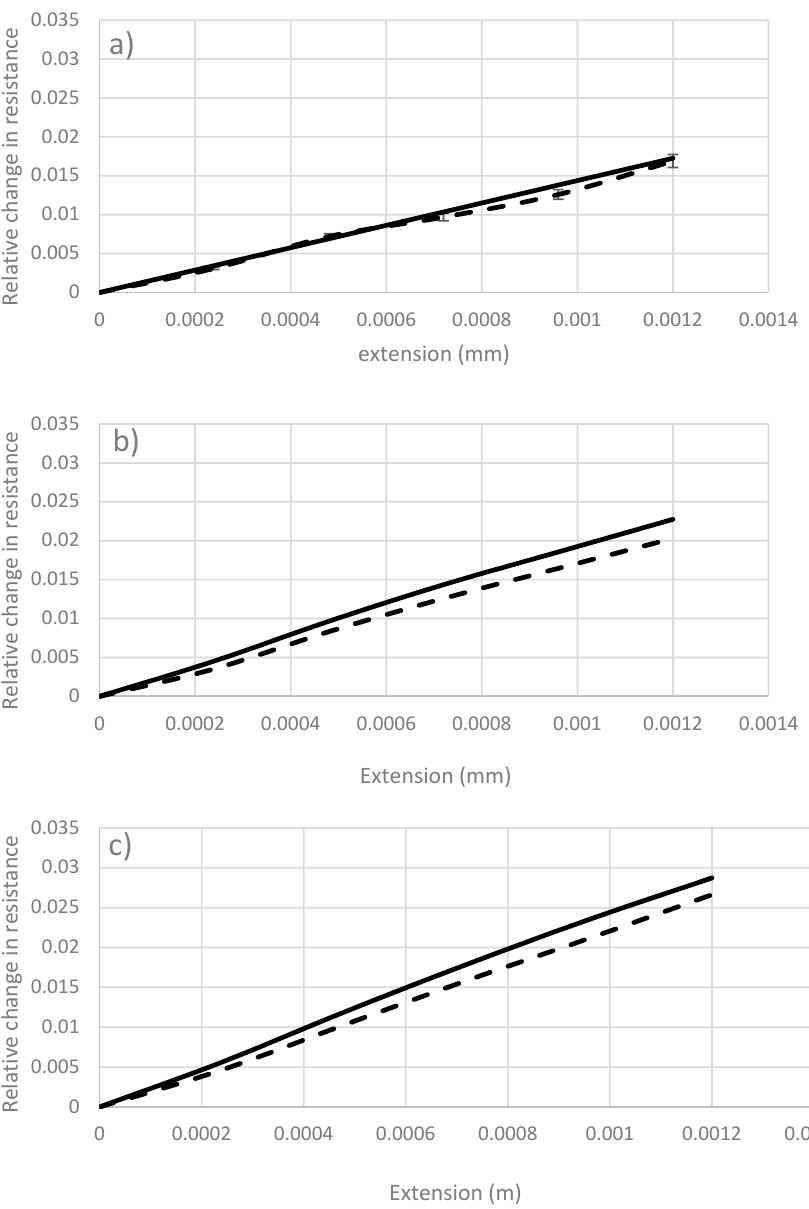
Figure 4. Stress–strain curve of fibers with different number of filaments: ( a ) 1 K, ( b ) 3 K, ( c ) 6 K and ( d ) 12 K; : bare fiber and : carbon fiber sensor.